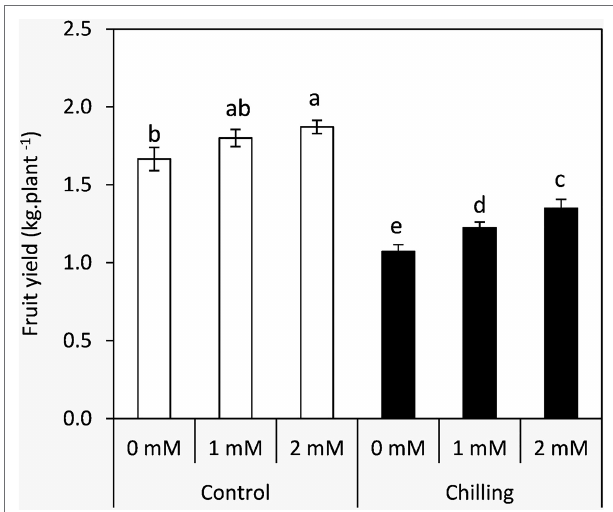
FIGURE 8 | Effect of γ -aminobutyric acid (GABA) as a foliar application at 1 and 2 mM on fruit yield of tomato plants cv “Super marmende” growing under normal (25°C/20°C day/night ) and chilling conditions (5 days/4ºC for 6 h/day) followed by 2 days recovery. Data followed by the same letters ± SE are not significant according to Duncan multiple rang test at P ≤ 0.05. The white columns refer to the control conditions and the black columns refer to the chilling